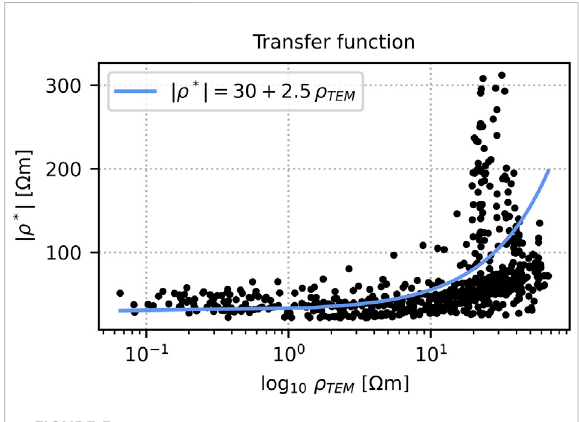
FIGURE 5 Linear transfer function used to scale ρ TEM to fi t the order of magnitude of | ρ p | observed in the electrical